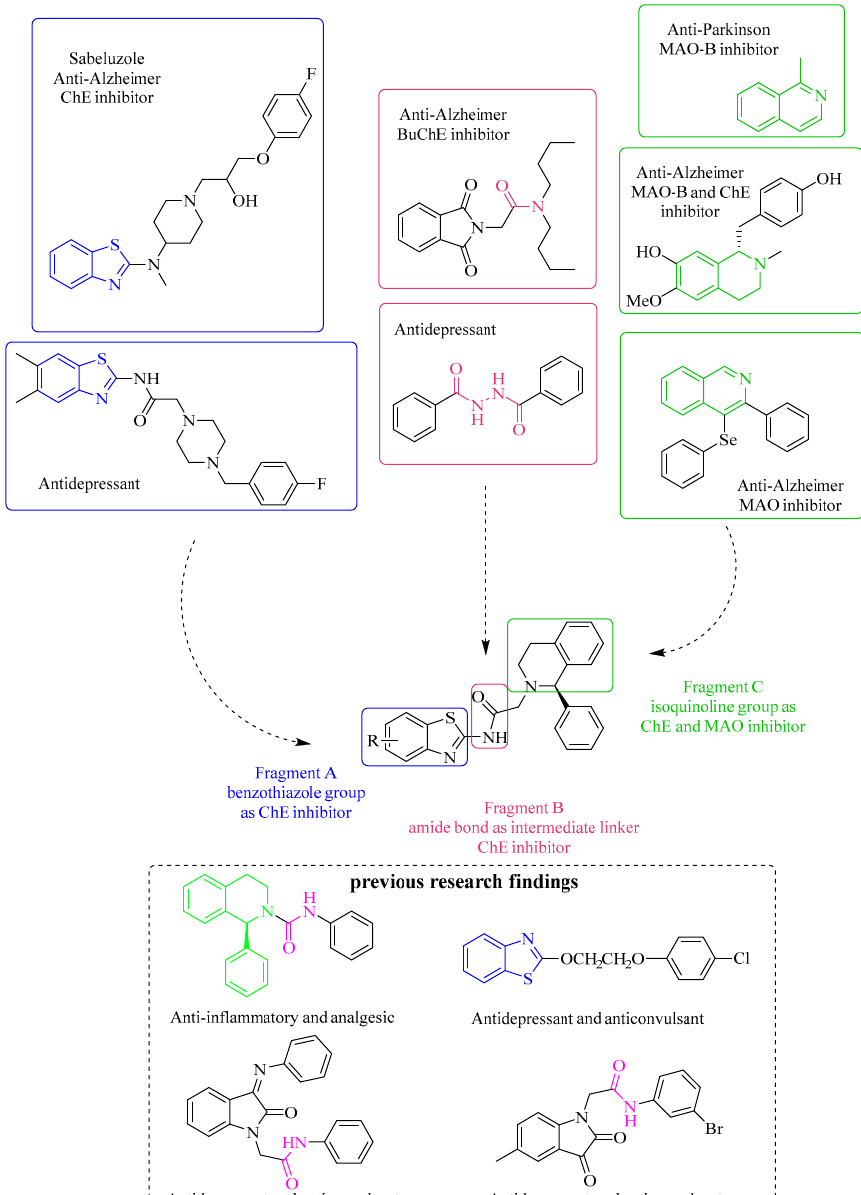
Figure 1. Design strategies for innovative compounds of multi–target–directed ligands (MTDLs). (ChE: cholinesterase; MAO: monoamine oxidase; MAO–B: monoamine oxidase B; BuChE: butyryl- cholinesterase.).